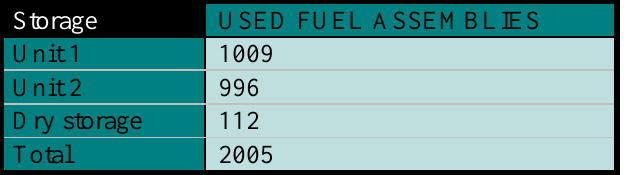
Figure 2. Used fuel assemblies in storage at Koeberg Nuclear Power Plant [ 11 ]